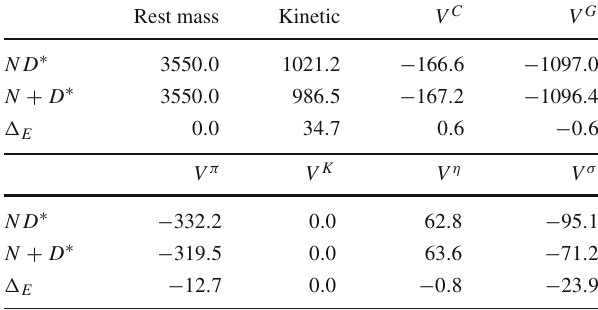
Table 9 The energy components of N D ∗ state (unit: MeV) Rest mass